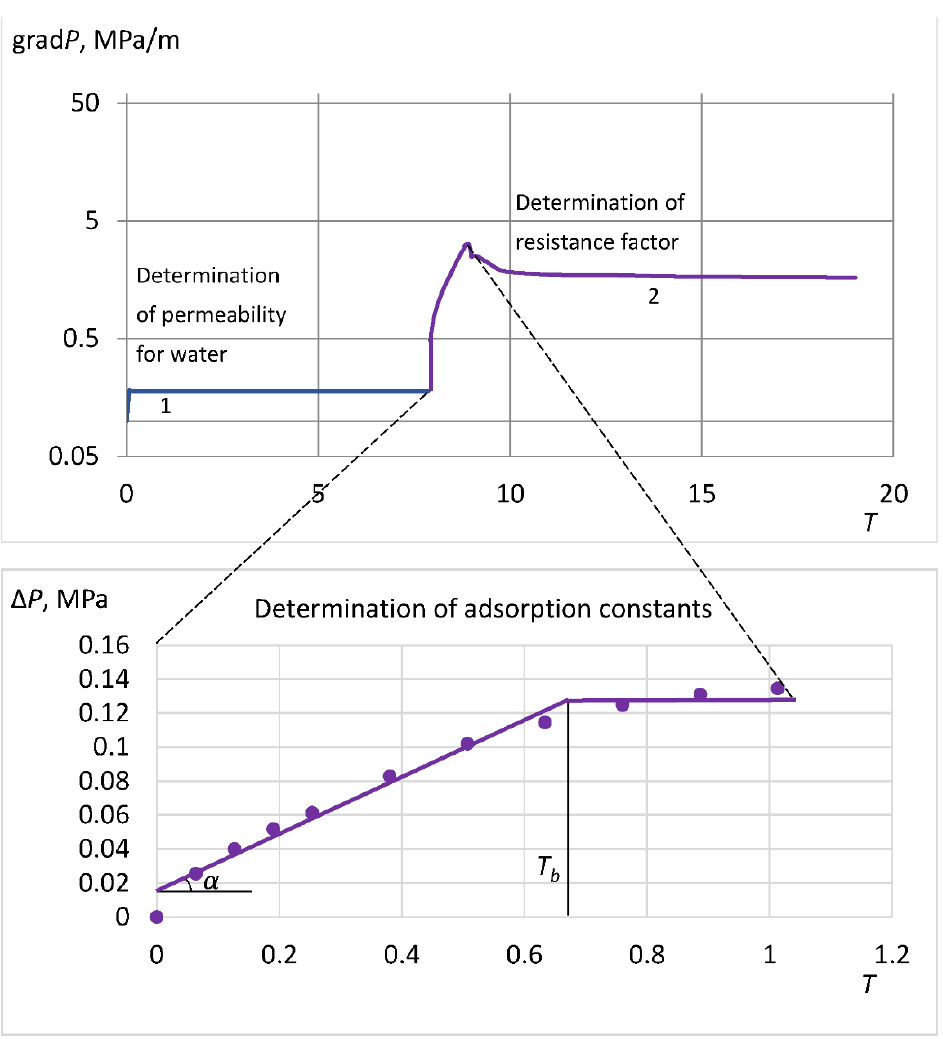
Figure 7. Graphical solution of inverse problems to determine the polymer adsorption parameters (stage 1 and blue line — determination of water permeability, stage 2 and purple line — determination of the resistance factor).